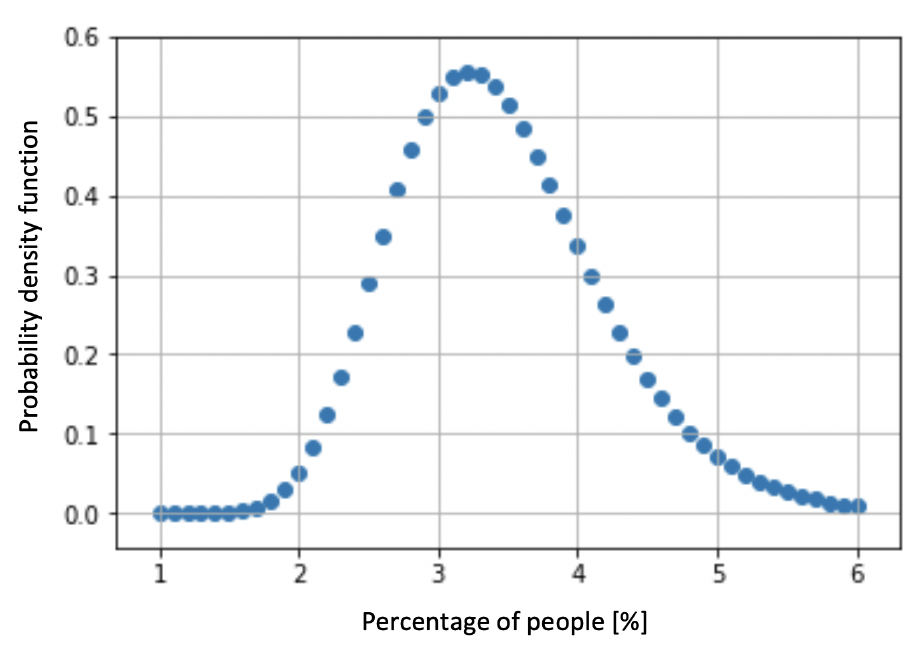
Figure 9. Birnbaum–Saunders probability